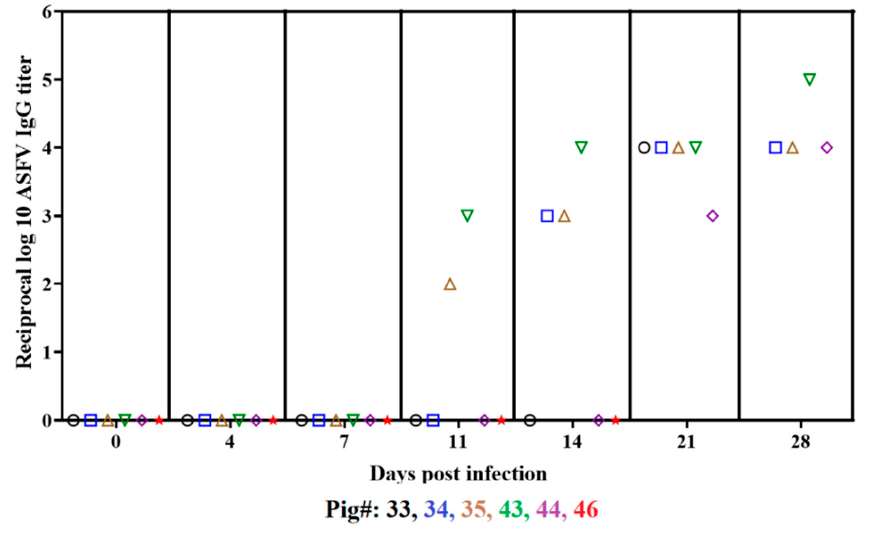
Figure 5. Serological detection of virus-specific antibody titers in the serum of animals surviving infection after inoculation with ASFV-DR21 ON or by contact with IM inoculated animals. Data are presented as individual values of antibody titers detected by ELISA and expressed as the reciprocal of the log 10 of the highest dilution where the OD630 nm reading of the tested sera at least duplicated the reading of the mock infected (obtained at day 0 post infection) sera. ASFV IgG titers with different colored symbols representing individual animals.